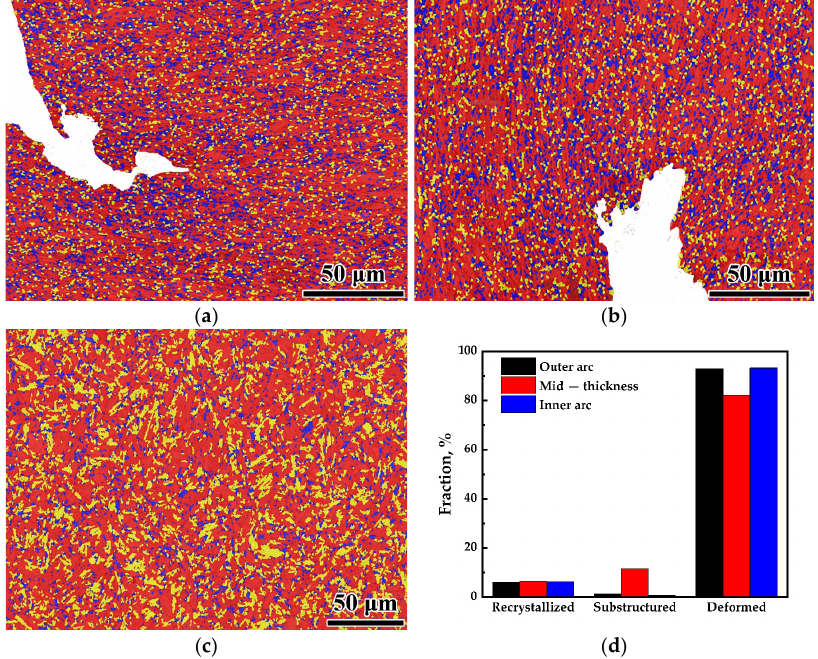
Figure 7. The Taylor factor (TF) maps at the bending axis of the 5% Ni steel: ( a ) outer arc surface, ( b ) inner arc surface, ( c ) mid-thickness, and ( d ) TF distributions. Figure 8 shows the distribution map of the deformed grains, recrystallized grains, and substructures represented with red, blue and yellow colors, respectively. Obviously, there were more deformed grains at the outer- and inner-arc surfaces than that at the mid-thickness.